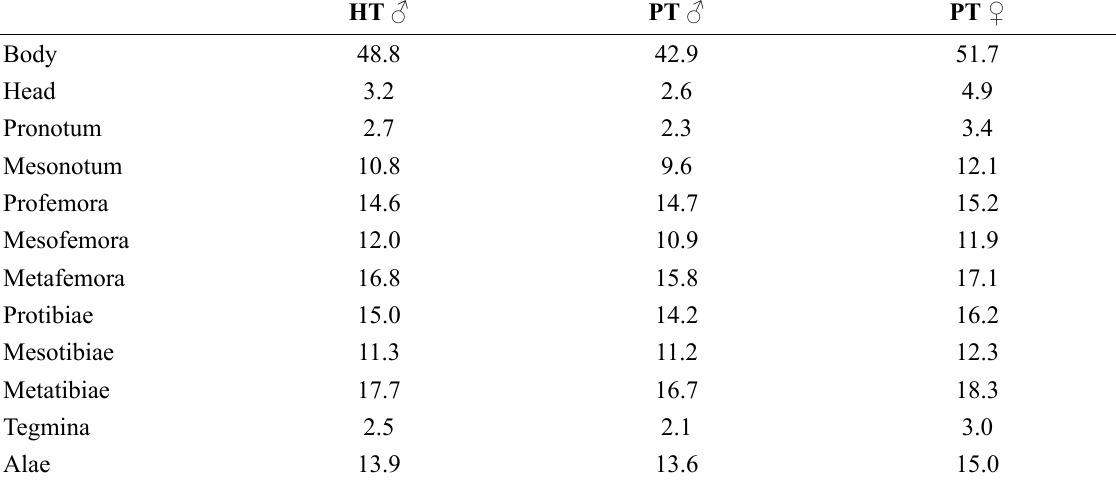
Table 3. Measurements (mm) of Otraleus christianae sp. nov. HT = holotype; PT =